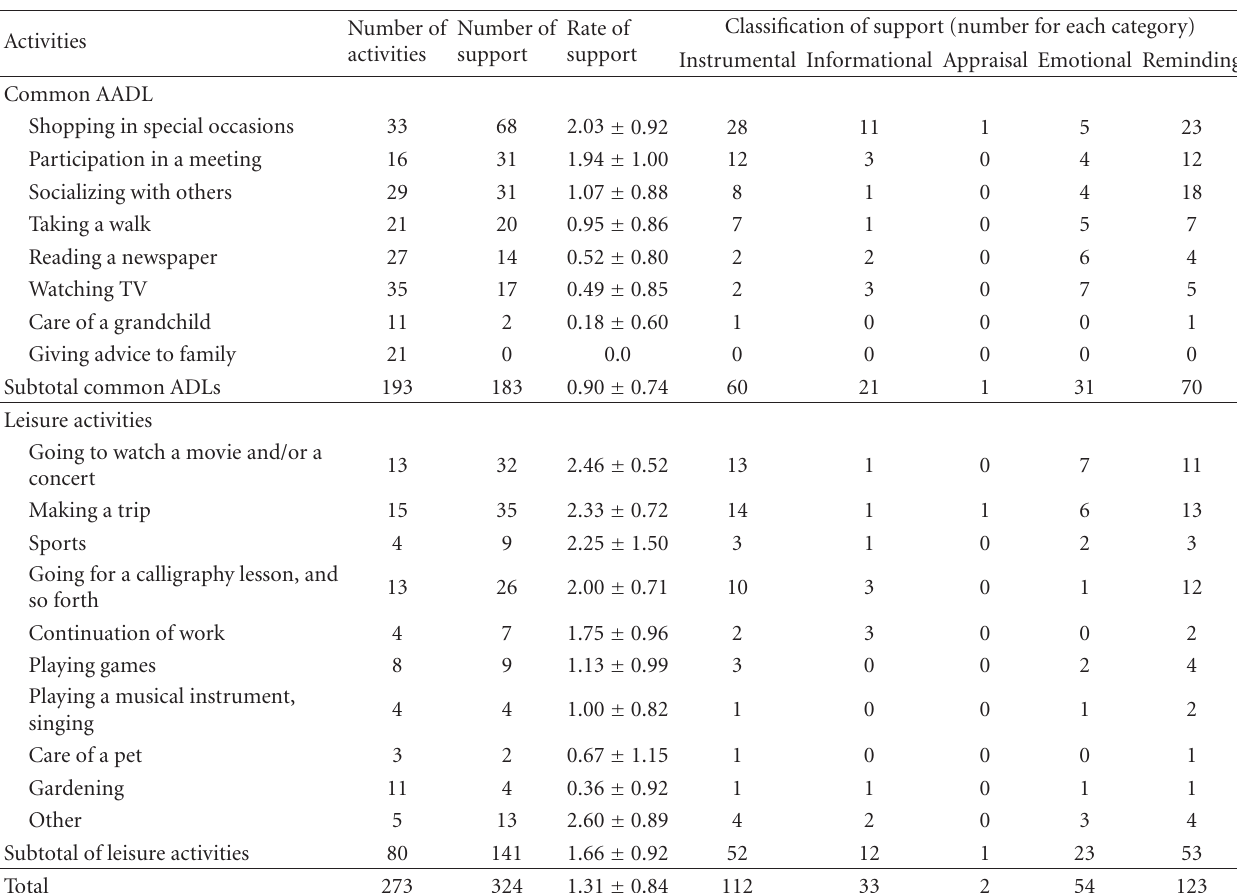
Table 4: Support provided by family caregivers to maintain advanced activities of daily living (AADL) of patients.